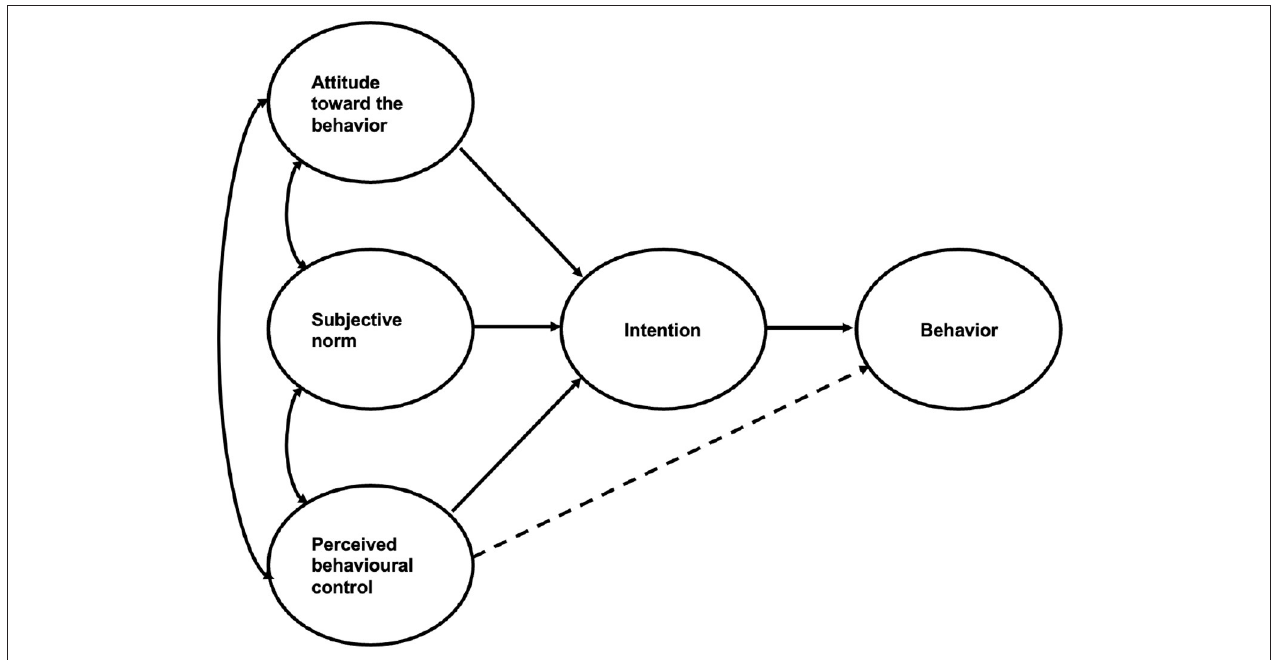
FIGURE 1 | The Theory of Planned Behavior